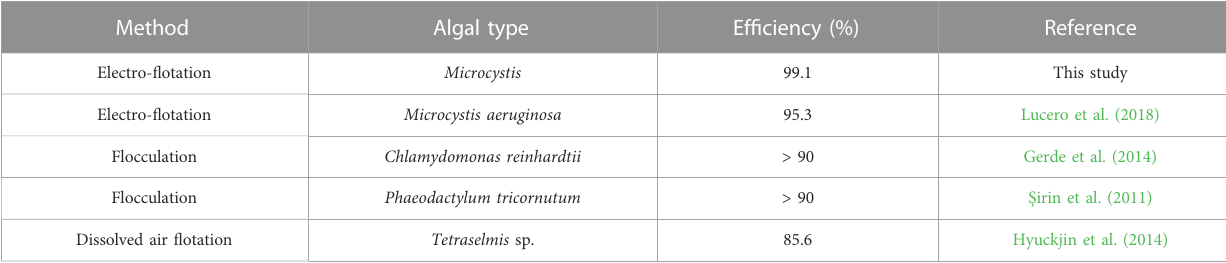
TABLE 4 Comparison of different methods of removing